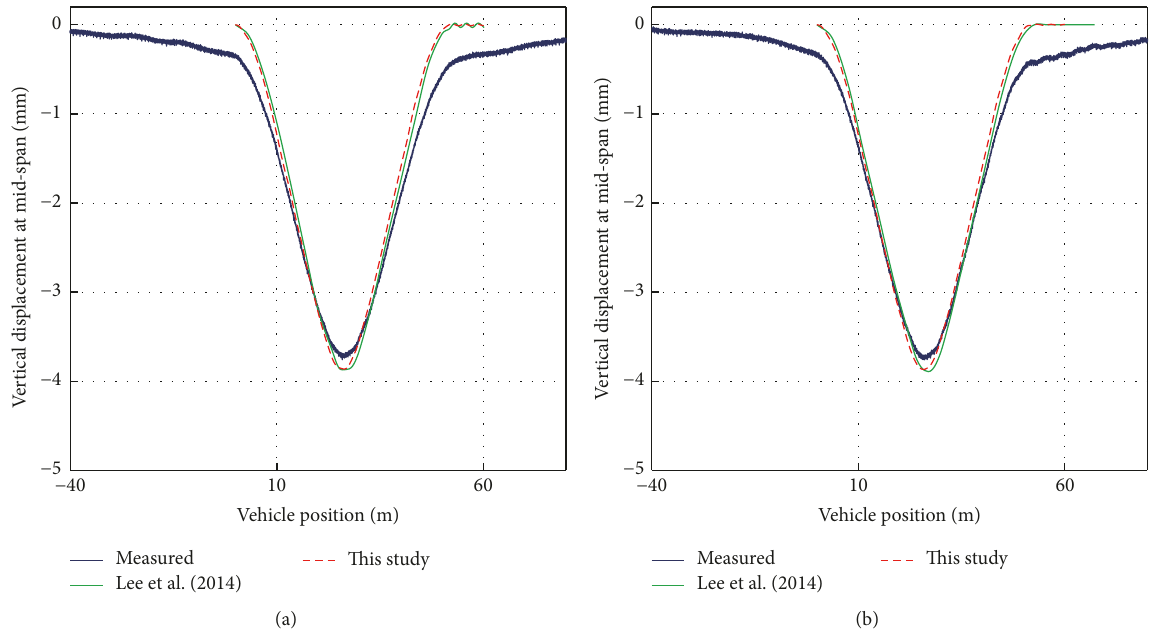
Figure 8: Comparison of dynamic displacements at guideway mid-span: (a) V = 60km/h, (b) V = 67km/h.